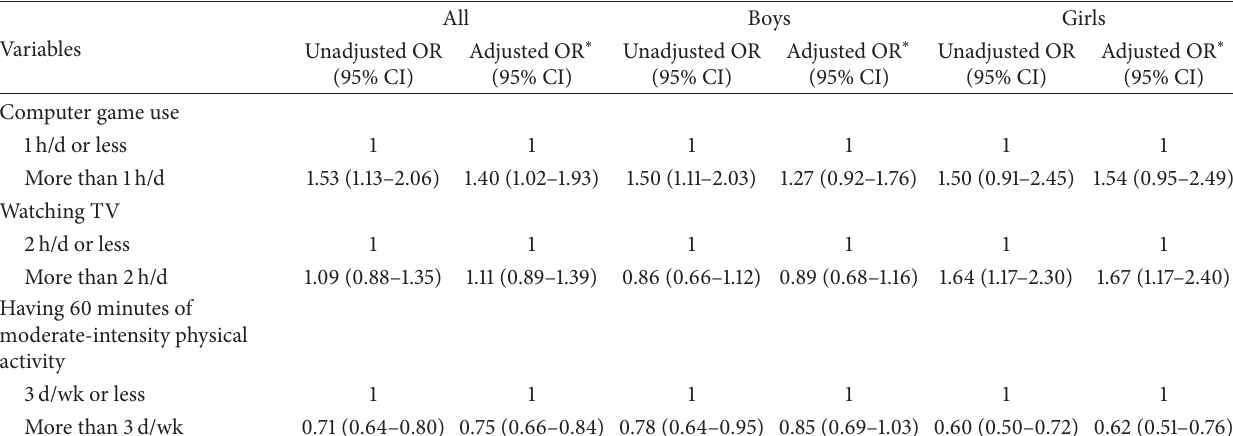
Table 2: Odds ratio for the associations of computer game use and television viewing with overweight by